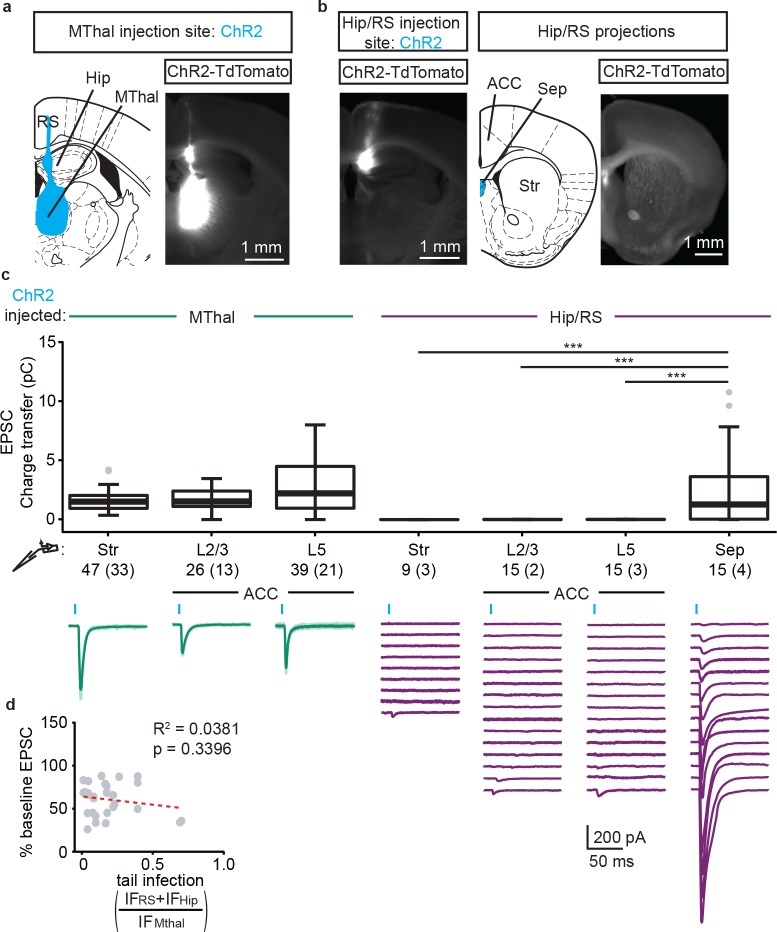
Verification of origins of optically-evoked response.(a) Representative fluorescent image (right panel) of a typical MThal ChR2 injection in which virus was injected in the MThal while also infecting a ‘tail’ region including hippocampus (Hip) and retrosplenial cortex (RS). The fluorescence at the injection site is saturated to reveal the ‘tail’ region. Schematic of ChR2(H134R)-TdTomato expression shown in blue on a section of the mouse brain atlas (left). (b) Example fluorescent image of ChR2(H134R)-TdTomato expressed only in the ‘tail’ region and corresponding image of projection areas (right) that highlight projections in the septum (Sep) but lack of visible projections in the ACC and striatum following Hip/RS ‘tail’ injection. (c) Charge transfer of EPSCs (upper panel) recorded in striatal MSNs (Str), layer 2 and 3 (L2/3) or layer 5 (L5) pyramidal neurons following optical stimulation in mice injected with ChR2 in either MThal or Hip/RS, as well as Sep as a positive control for the Hip/RS injections. Hip/RS ‘tail’ injections resulted in only occasional small amplitude oEPSCs in the Str and ACC. Kruskal-Wallis test, H = 69.654, df = 6, p<0.001; post-hoc Dunn’s test, Bonferonni-corrected. ***p≤0.001. Box plot with median, 1st and 3rd quartile, and whiskers represent 1.5 times interquartile range. Representative average recordings (lower panel, dark green, average of 10 single trials) from the MSNs, L2/3 and L5 neurons upon optical stimulation of ChR2(H134R) injected in the MThal as shown in (a). Averaged oEPSCs (lower panel, purple, average of 10 single trials) of all individual neurons recorded in Hip/RS injected mice, as shown in (b). Blue bars: 1 ms of 470 nm light stimulations. (d) Plot of the DAMGO effect on baseline oEPSC amplitudes recorded in all L2/3 and L5 pyramidal neurons, as a function of the ratio of integrated fluorescence intensity (IF) of ChR2(H134R)-TdTomato fluorescence in RS +Hip (IFRS +IFHip) relative to MThal (IFMThal) in all the Mthal injected groups. There was no correlation between the amount of ‘tail’ infection and the degree of oEPSC inhibition by DAMGO. Linear regression model, R2 = 0.034, F (1, 27)=0.945, p=0.340.